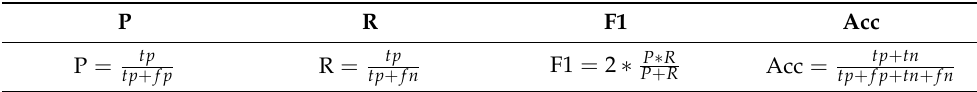
Table 3. Precision, recall, F1 score, and accuracy